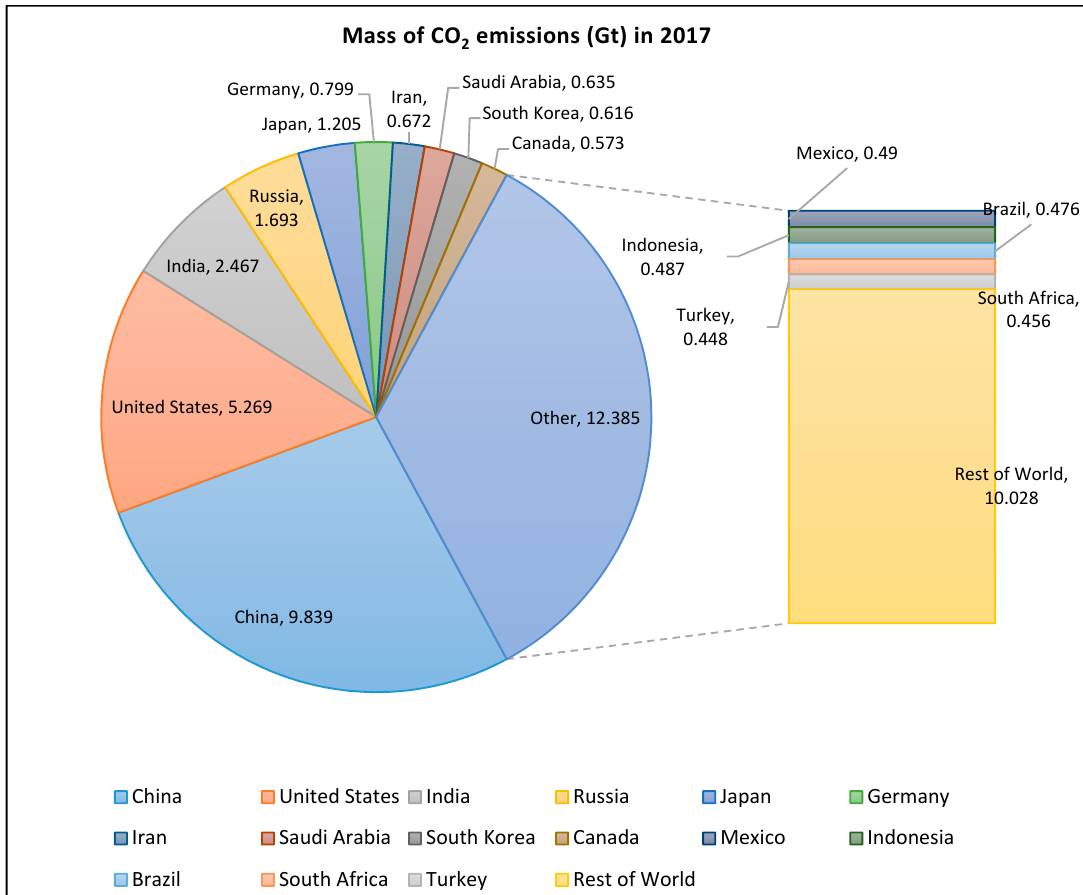
Figure 1. Main countries responsible for global CO 2 emissions, modified from [22].